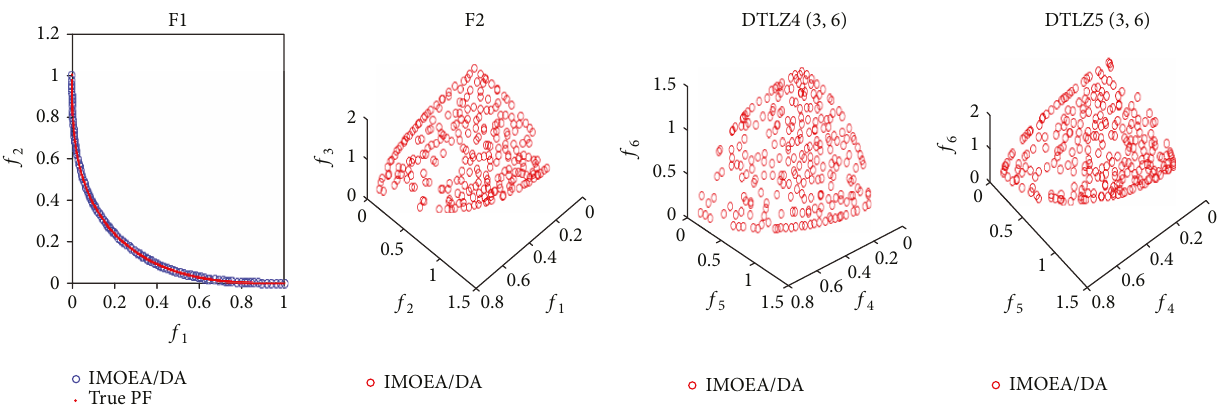
Figure 5: According to the median values of IGD metric, nondominated solutions obtained by IMOEA/DA on F1, F2, and two six-objective